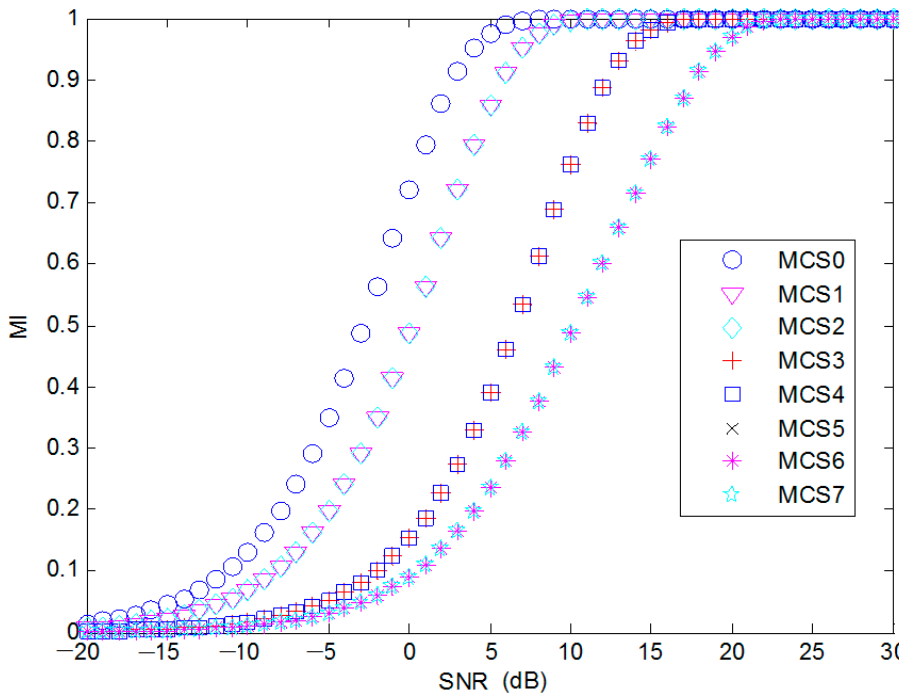
Figure 5. Signal-to-noise ratio (SNR)-to-mutual information (MI) conversion for MCS 0–7. Figure 6 is obtained from Monte Carlo simulations under the additive white Gaussian noise (AWGN) environment, from which the PER is acquired and the throughput can be expressed in terms of the PER as in Equation (2).